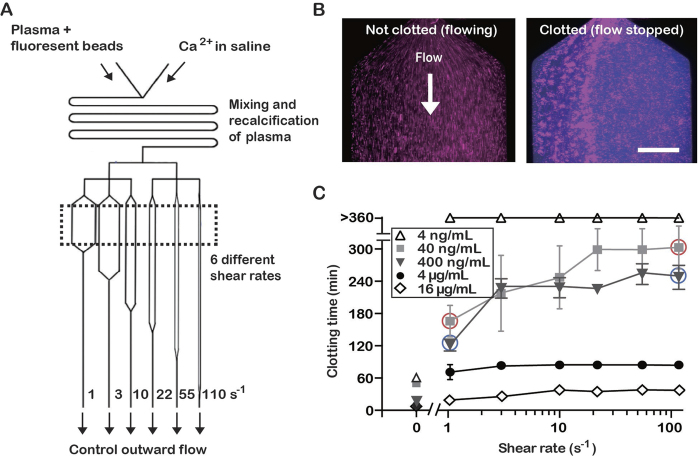
The microfluidic system used to measure clotting over a range of shear rates.(A) Schematic of the microfluidic system. Box (dashed lines) indicates the region where shear rates were varied and clot times were measured. (B) Fluorescence images showing that clotting was detected by the cessation of flow of tracer beads (pink) and by the cleavage of a substrate for thrombin (blue). Scale bar is 250 μm. (C) Assessing the range of clotting times in this flow system by adding various concentrations of FVIIa to the plasma. Data points indicate mean ± SEM, n = 3–4. Red circles indicate p = <0.05 between the data points, and blue circles indicate p = <0.01 between the data points.